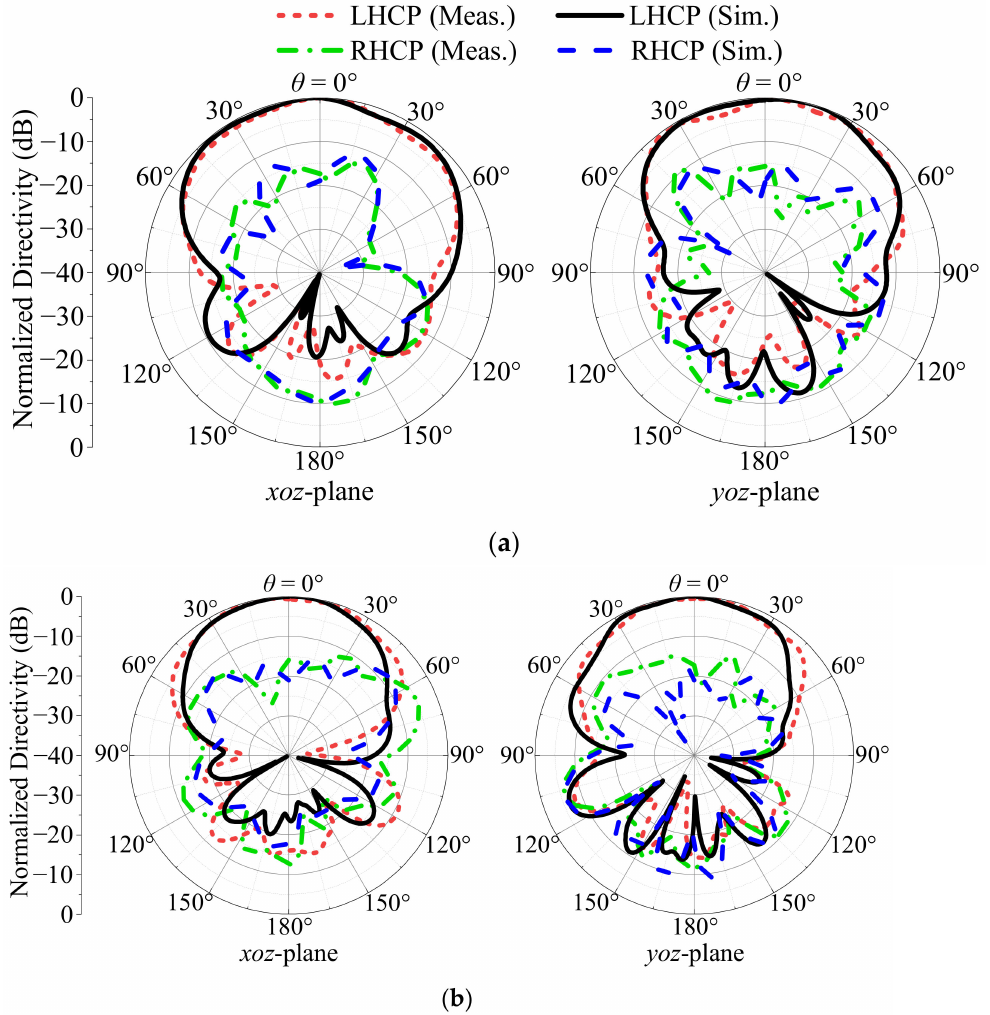
Figure 11. Simulated and measured radiation patterns of the proposed DRA: ( a ) Radiation patterns at 27.5 GHz; ( b ) Radiation patterns at 40